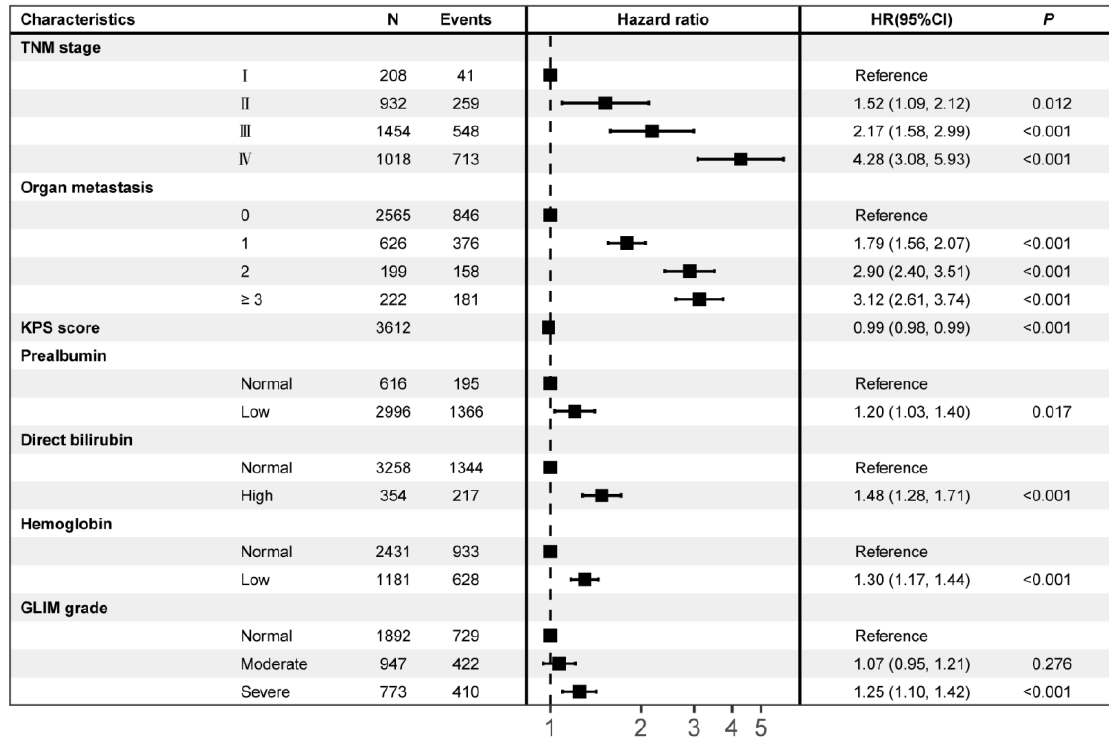
Figure 1. Kaplan – Meier curve analysis on the Global Leadership Initiative on Malnutrition (GLIM) grade. ( A ) Survival stratified by malnutrition. ( B ) Survival stratified by the severity of malnutrition. GLIM, the Global Leadership Initiative on Malnutrition.